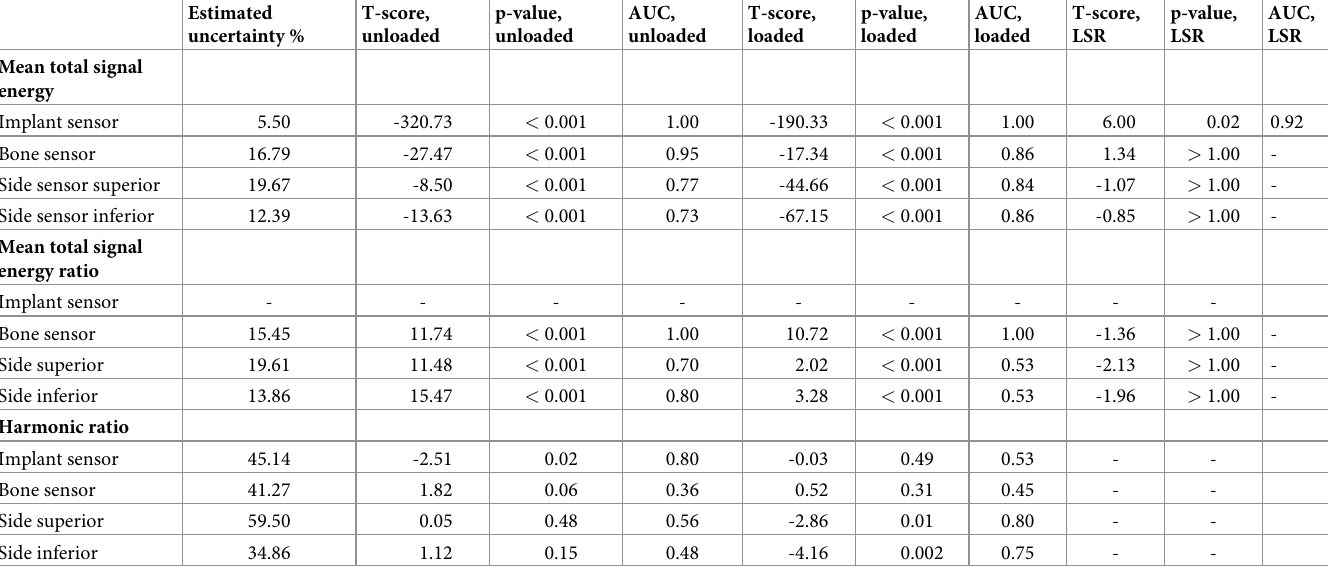
Table 1. Measurement uncertainties, statistical details, and differentiation performance for each acoustic characteristic, sensor location, and loading. P-values were Bonferroni corrected with n = 35. Values for which the p-value exceeds 1.00 are not displayed. Estimated uncertainty